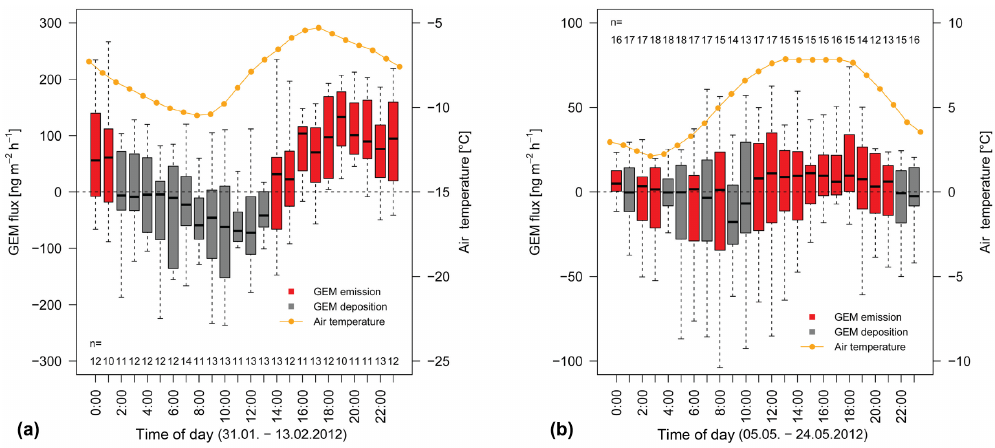
Figure 8. Diurnal patterns of GEM flux during the campaign in Basel (a) and Degerö (b) using the 6-hourly smoothed GEM flux time series. Red and gray colored box plots indicate median Hg emission and Hg deposition at different times of the day, respectively. Hourly averages of air temperatures are given (orange). Horizontal dashed line indicates the zero line of GEM flux and/or air temperature. Box plot description in caption of Fig.